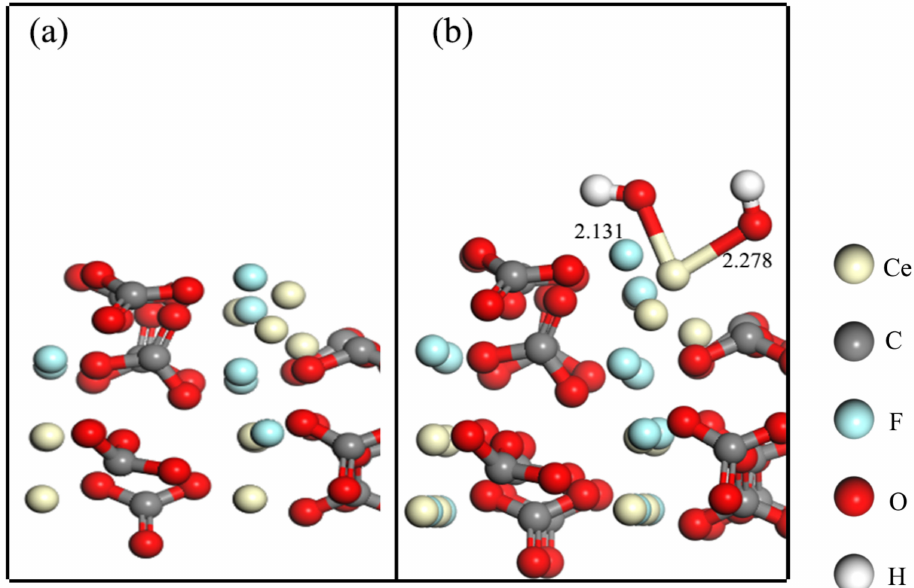
Figure 2. The (100) surface ( a ) and hydroxylated (100) surface ( b ) of